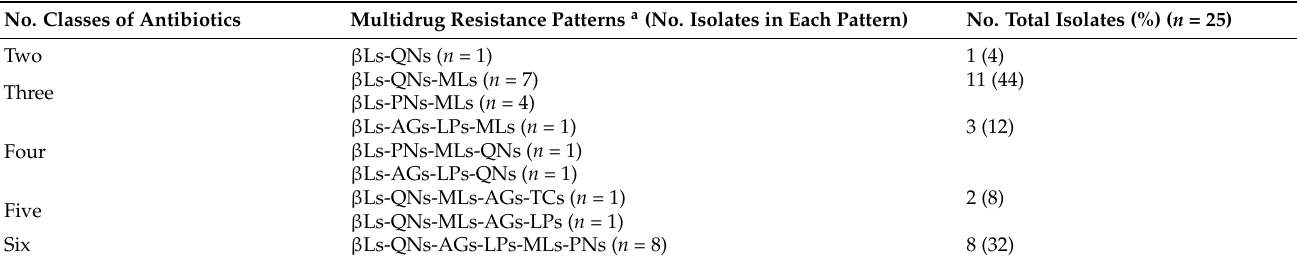
Table 1. Multidrug resistance class patterns of C. sakazakii strains isolated from PIFM samples. No. Classes of